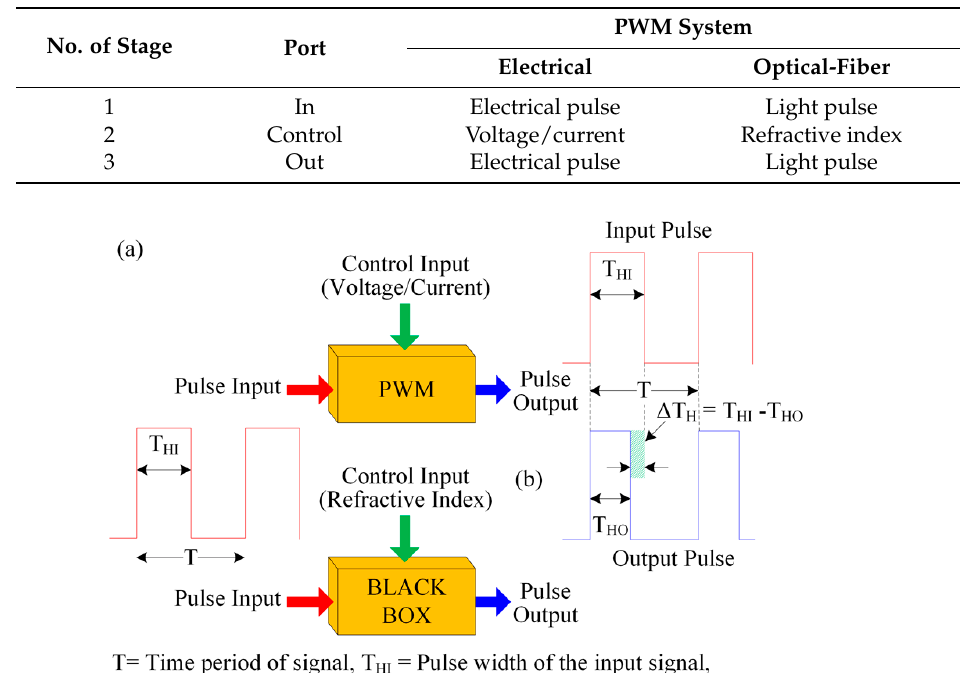
Table 1. Three levels of analogy within the electrical and optical-fiber PWM sensing systems.